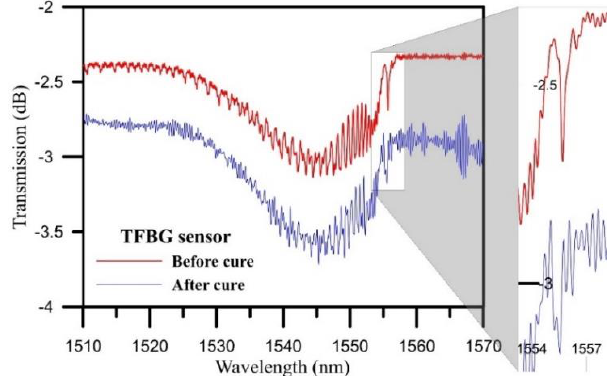
Table 1. TFBG sensor residual stresses and residual strains.